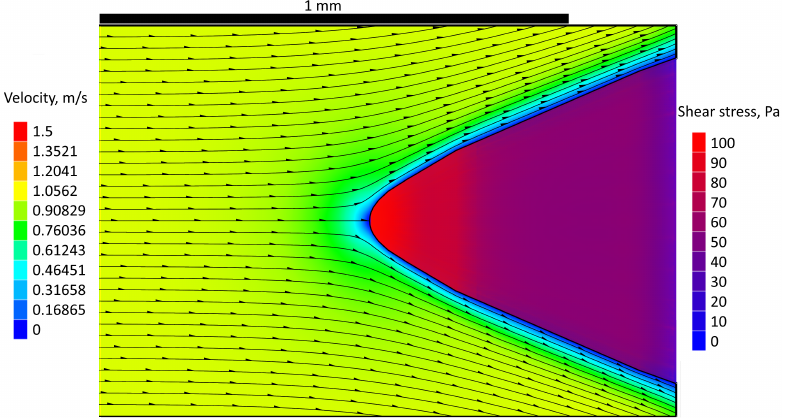
Figure 2. The velocity contour plot and streamlines for the melt area and the shear stress contour plot for the dendrite tip area. The fluid flow has a 0-degree slope to the dendrite axis.